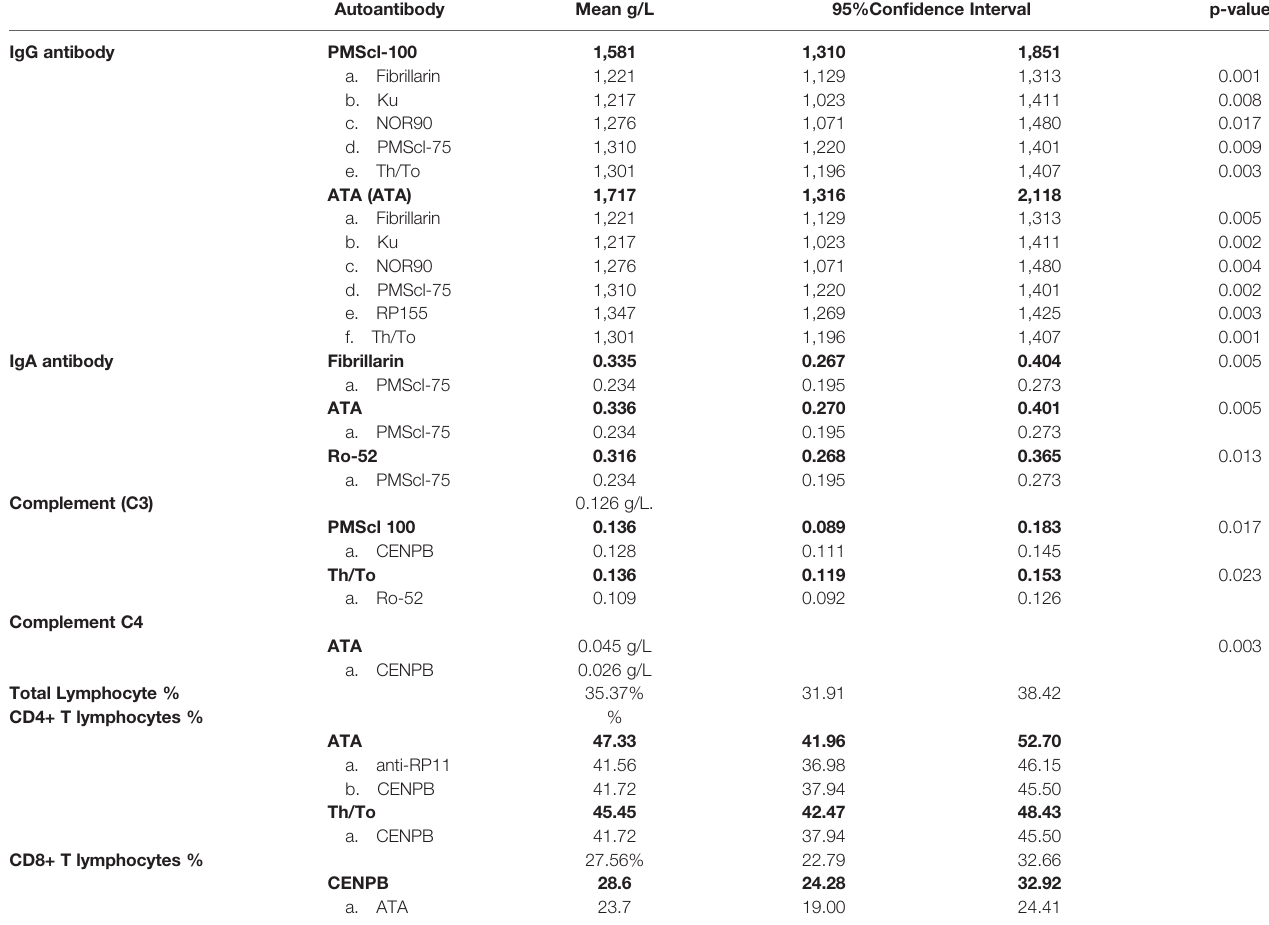
TABLE 2 | Comparison of total serum IgA, IgM, IgG antibody levels, complement C3, C4 and lymphocyte subset values in patients with different SSc-speci fi c